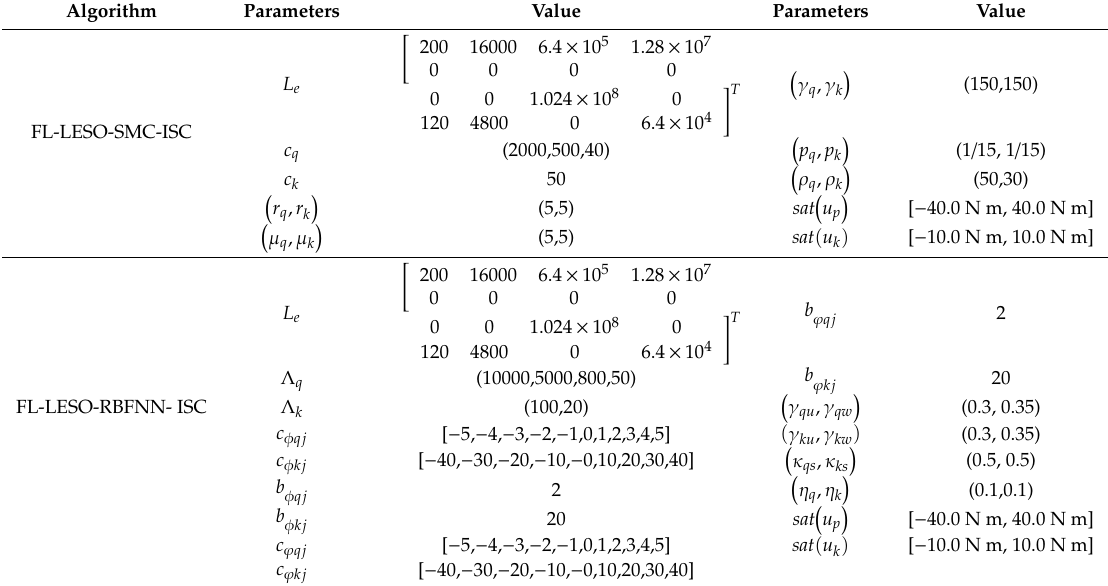
Table 3. VSJ system control algorithm